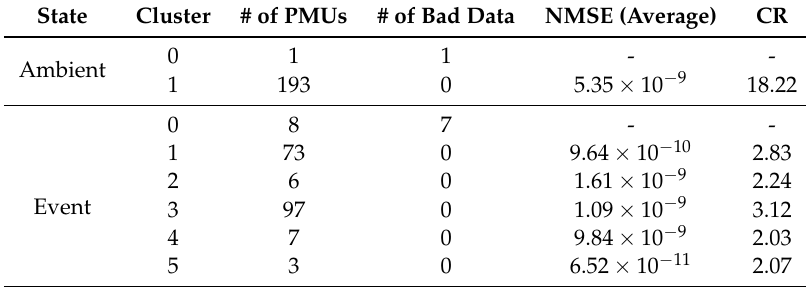
Table 2. Multiscale principle-component analysis (MSPCA) compression of clustered data (voltage).